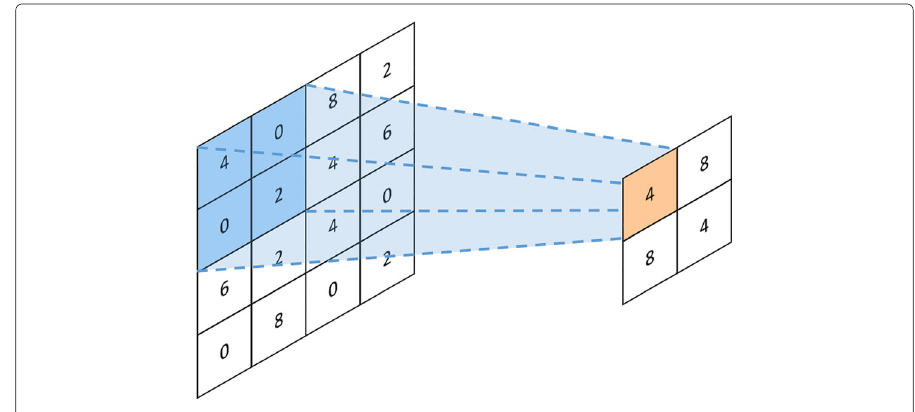
Fig. 3 The pooling